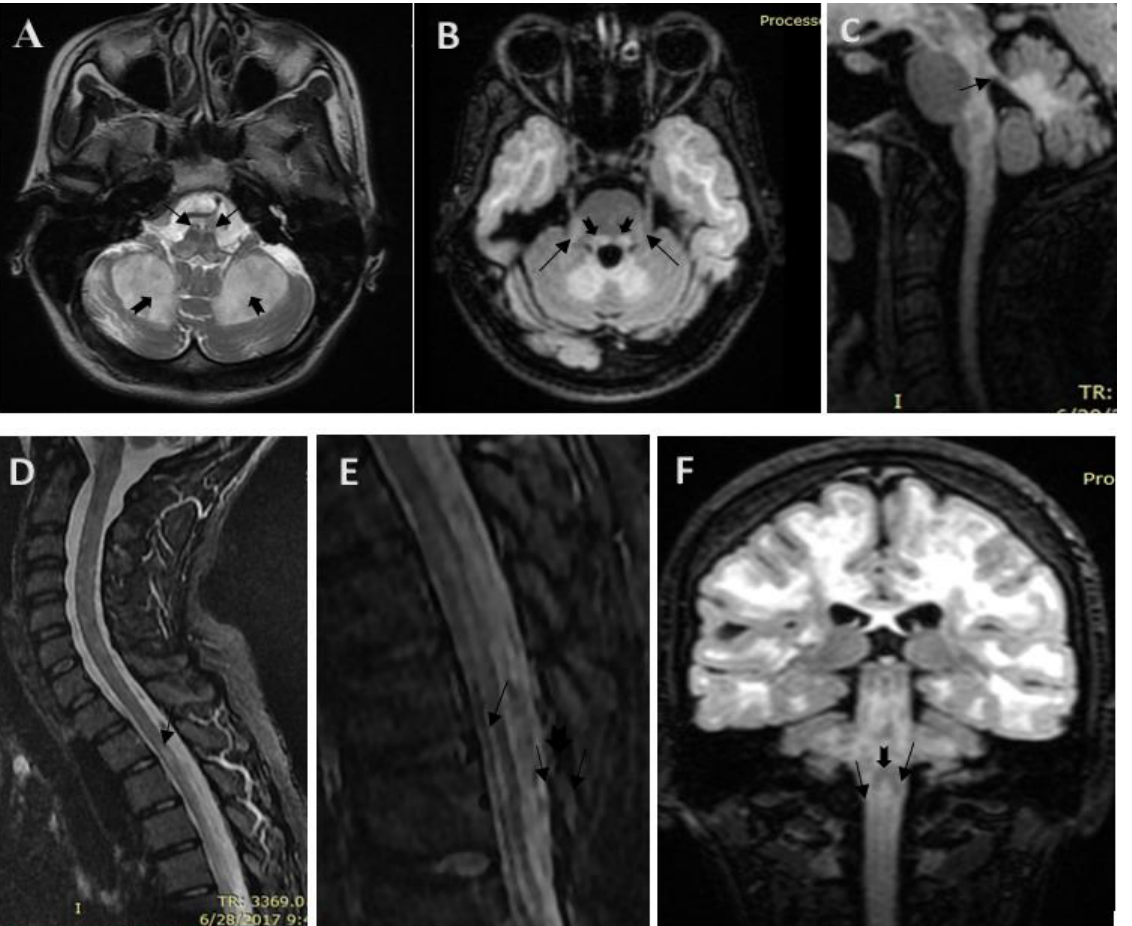
Fig. 1. Flair: (A) Hyper-intense confluent and (B) Spotty lesions in the cerebral white matter. (C, D) Sparing of the thalamus (thin arrows) ꓼ Posterior limb of the internal capsule involvement (thick arrows). (E) Splenium of the corpus callosum